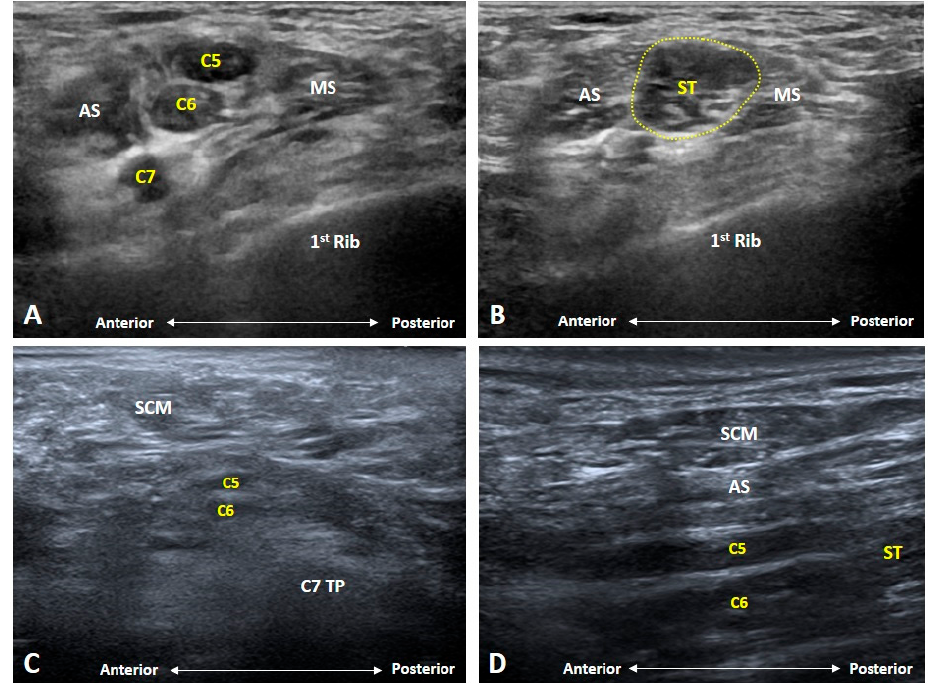
Figure 10. Ultrasound imaging of radiation-induced brachial plexopathy. Nerve fascicles of the brachial plexus at the root ( A ) and trunk (yellow dashed area) ( B ) levels appear enlarged with thickened epineurium. The muscles surrounding the neck are atrophic and fibrotic in the short-axis ( C ) and long-axis ( D ) views. AS: anterior scalene muscle; MS: middle scalene muscle; SCM: sternocleidomastoid muscle; ST: superior trunk.